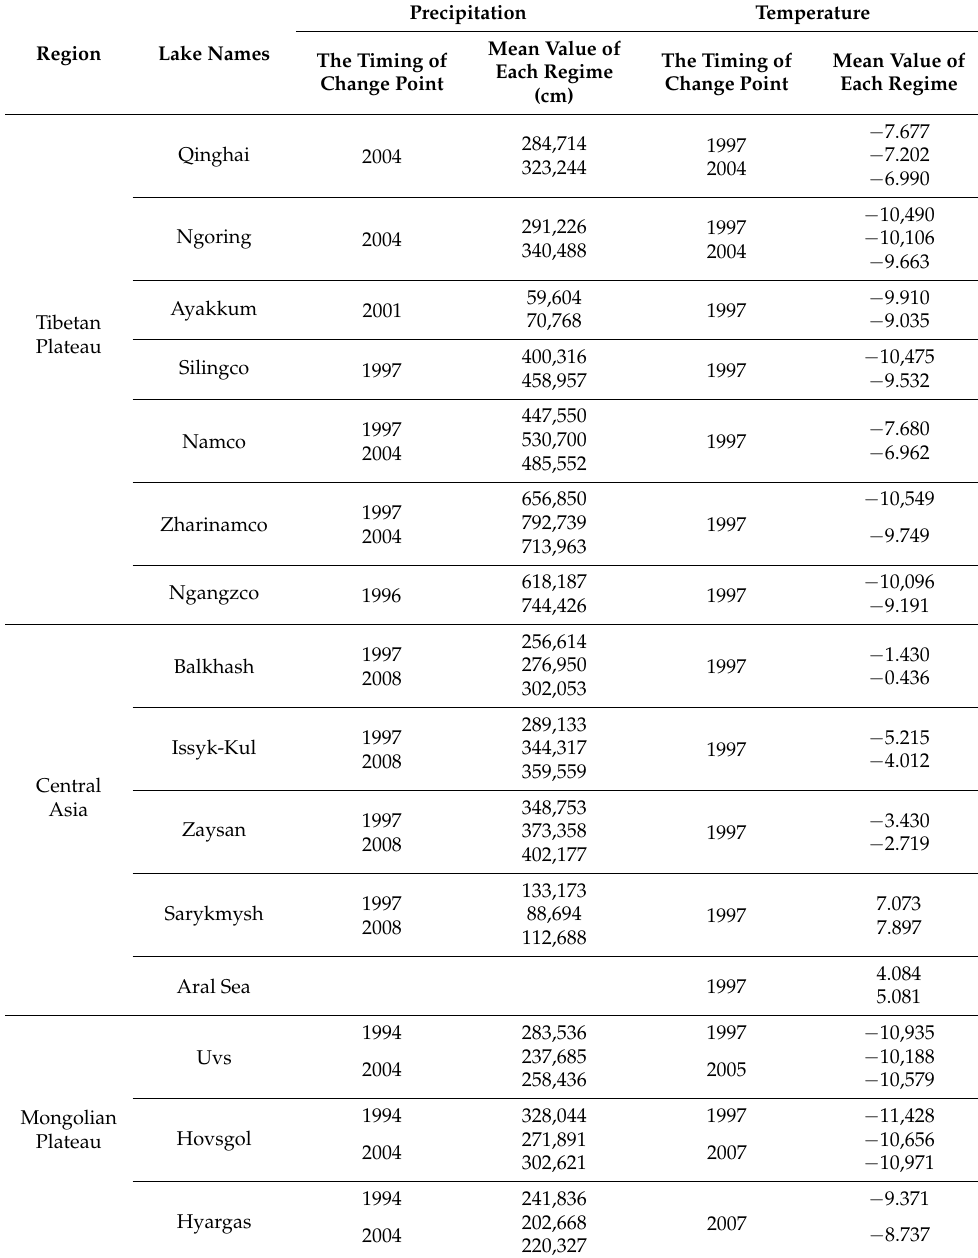
Table 4. The change points and the mean value of each regime in precipitation and temperature over the lake basin located at Tibetan Plateau, Central Asia, and Mongolian Plateau. Region Lake Names